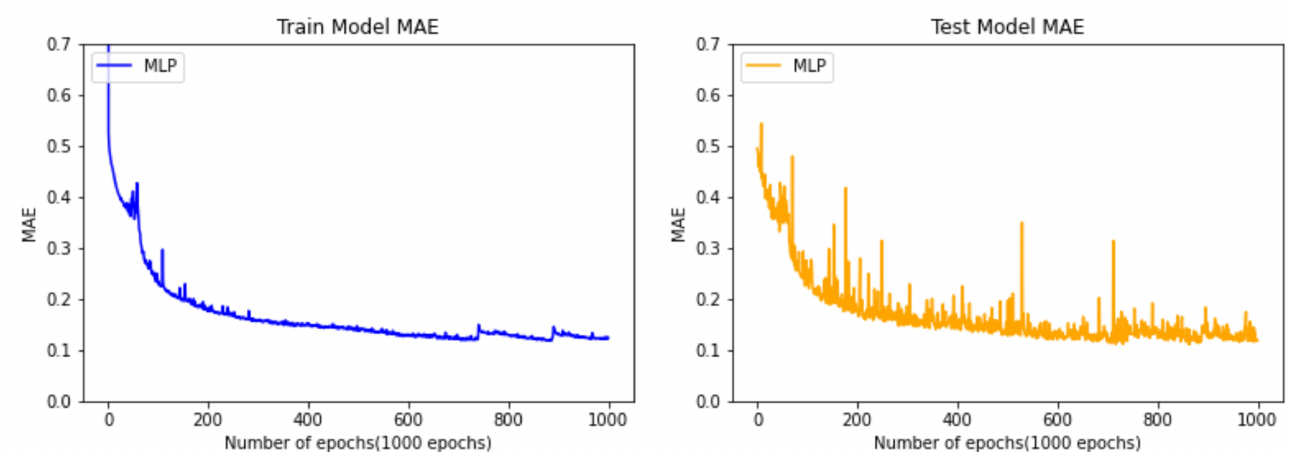
Figure 11. Comparison between train data and test data of the model using the MLP algorithm.